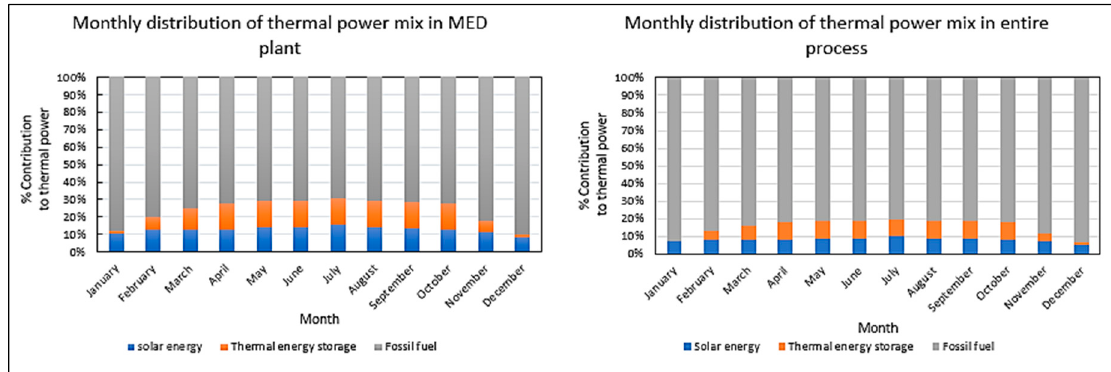
Figure 5. Optimal thermal power mix for the MED plant and the entire system with 60% RO 40% MED .